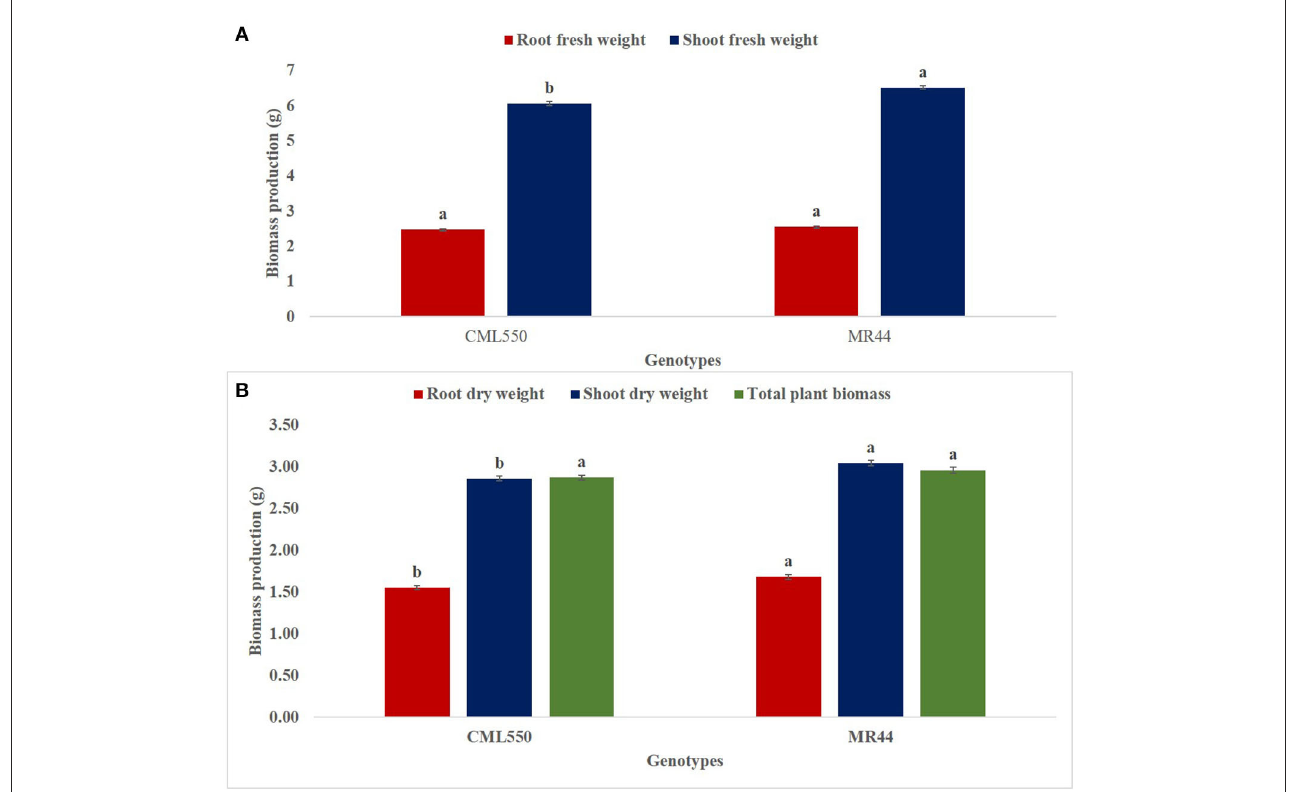
FIGURE3 Effect of genotype on (A) shoot and root fresh weight (B) root dry weight, shoot dry weight, and total plant biomass. Values presented as means ± standard error ( n = 96). Means with different letters are significantly different from each other [Tukey’s Studentized Range (HSD) test ( p < 0.05)]. B 0